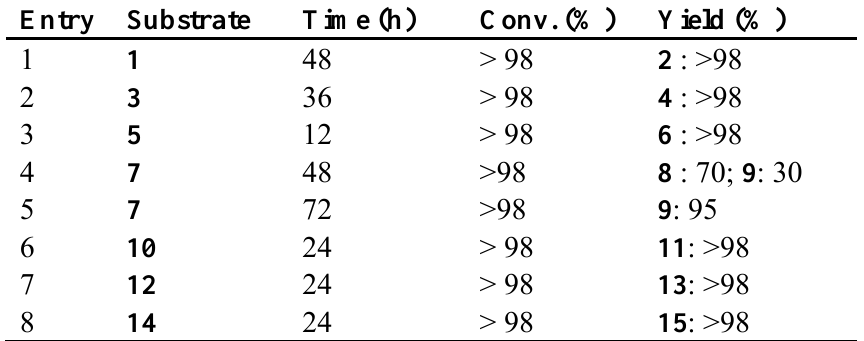
Table 1. Experimental data of methylation reaction of flavonoids depicted in Scheme